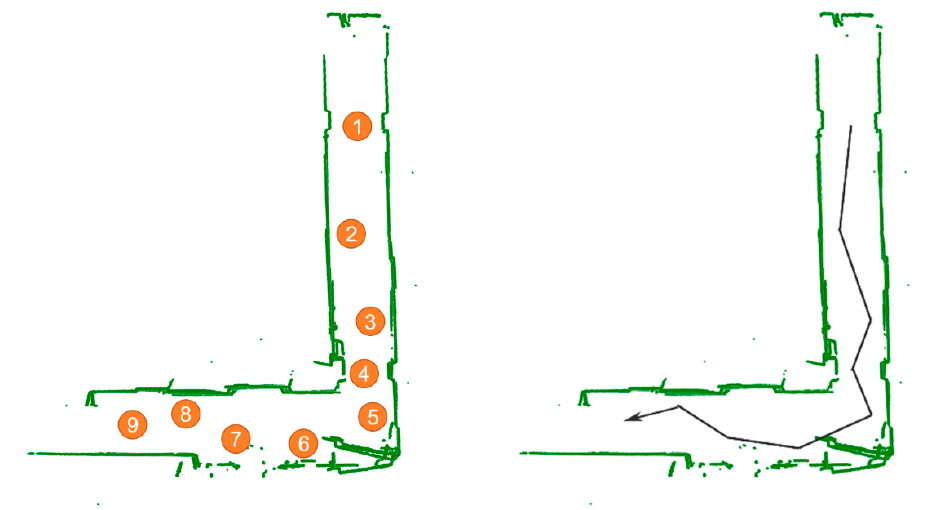
Figure 15. Integrated image of scanned result in first autonomous scanning experiment. The numbers indicating the positions after movement form the starting position of the autonomous scanner ( left ); also, the trajectory of the autonomous scanner is indicated ( right ).